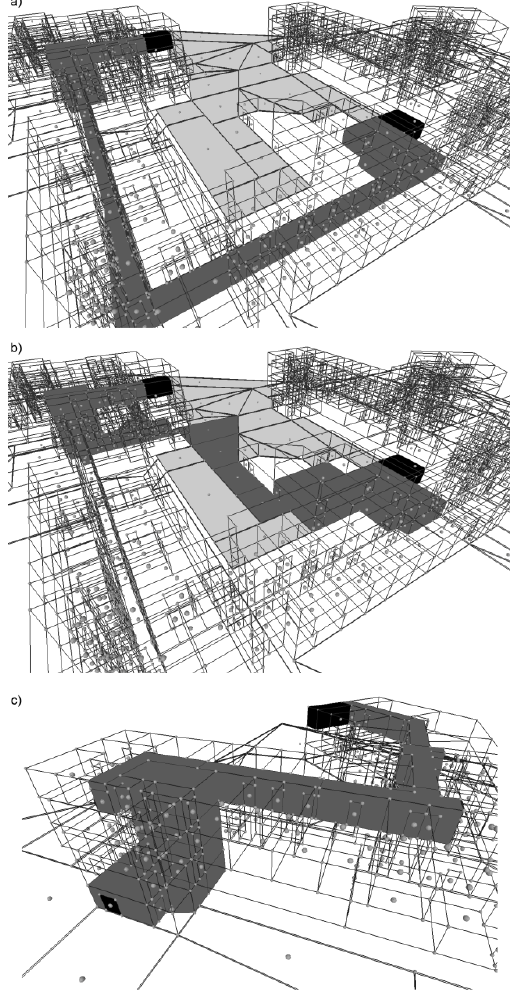
Figure 21. The shortest paths (dark-grey, external terrain represented by light-grey cells) between two rooms (black): ( a ) the path entirely inside the building; ( b ) the path calculated considering an external terrain; ( c ) the shortest path between a room and the closest exit.